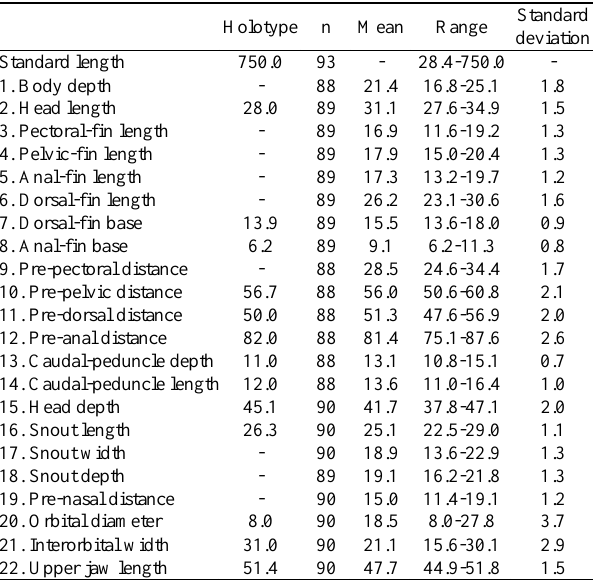
Table 7. Morphometric data of Hoplias lacerdae . Standard length in mm; values 1-14 are percents of standard length and values 15-22 are percents of head length. n = number of examined